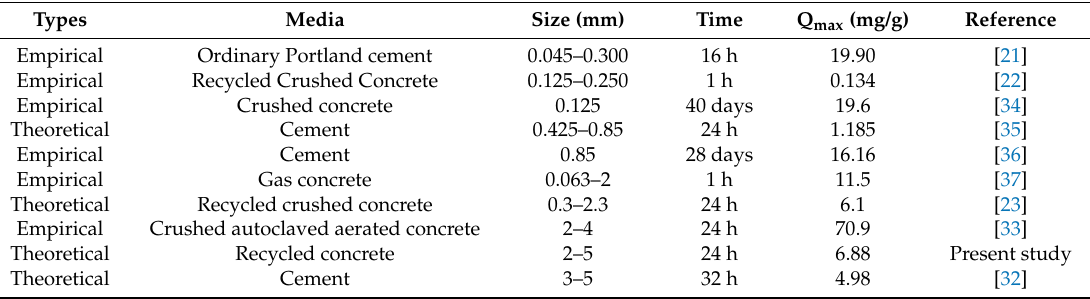
Table 5. Adsorptive capacity of various studies by concrete.